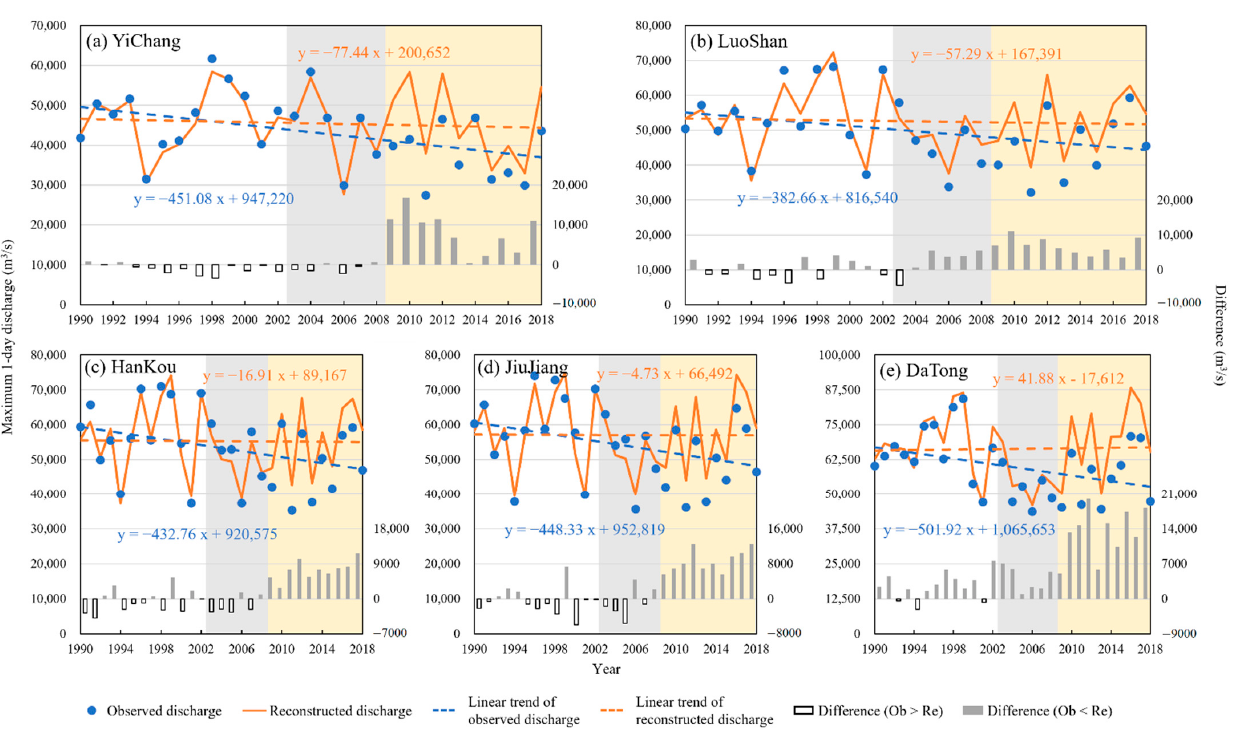
Figure 6. Analysis of the maximum 1-day discharge during flood season in the five gauging stations (the grey zones denote the initial operation period of the TGD from 2003 to 2008, and the yellow zones denote the full operation period of the TGD from 2009 to 2018).